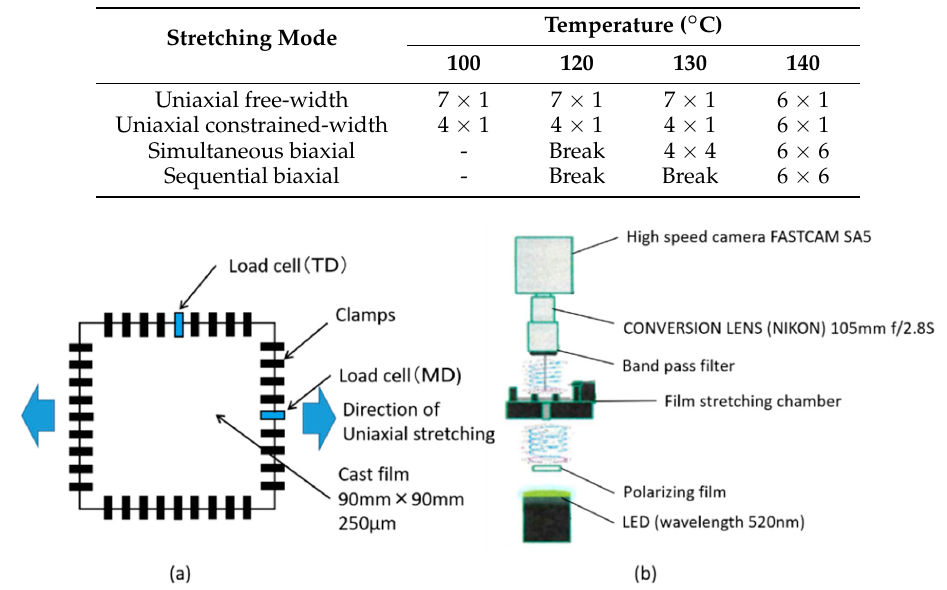
Table 1. Stretching mode, temperature and achieved draw-ratio in the experiment; stretching speeds are 1, 10, and 60 m/min for uniaxial mode, 1 m/min for biaxial mode.